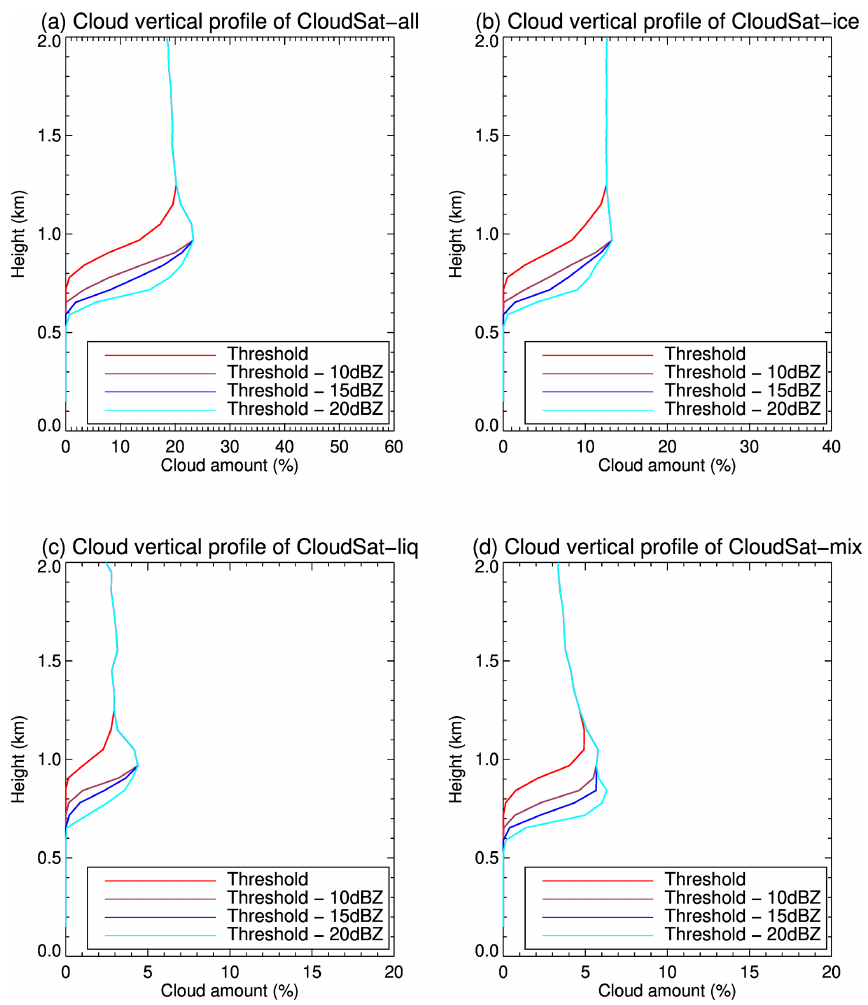
Figure 19. CloudSat cloud amount vertical profile with different vertical detection thresholds for (a) all, (b) ice, (c) liquid, and (d) mixed- phase